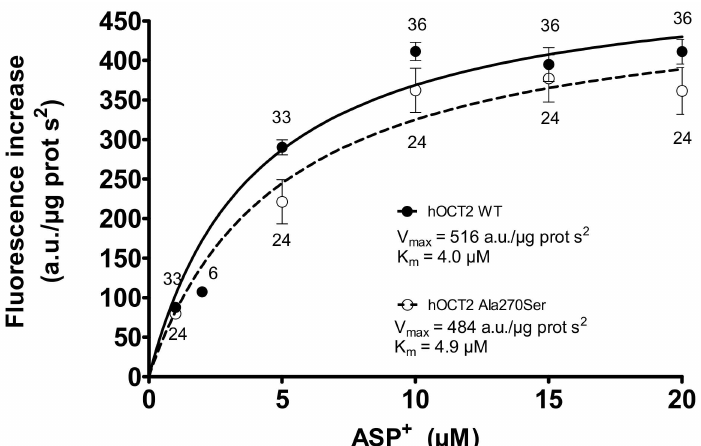
Figure 1. Specific ASP + uptake mediated by the wildtype form of hOCT2 (hOCT2 WT, closed circles) and by hOCT2 Ala270Ser (open circles) in stably transfected HEK-cells as calculated by adding rising ASP + concentrations to the cells and detecting the cellular fluorescence intensity. The specific uptake was calculated by subtracting the total uptake from the unspecific uptake determined in the presence of 1 mM TPA + . The number near the experimental points indicates the replicates measured in at least three independent experiments. Since both curves reached a plateau, it was possible to calculate K m (4.0 ± 1.0 and 4.9 ± 1.6 µ M for hOCT2 WT and hOCT2 Ala270Ser, respectively) and V max (516 ± 23 and 484 ± 50 arbitrary units / µ g protein s 2 for hOCT2 WT and hOCT2 Ala270Ser, respectively) of ASP + uptake. These values resulted not to be significantly di ff erent when compared using the extra sum-of-squares F test (GraphPad